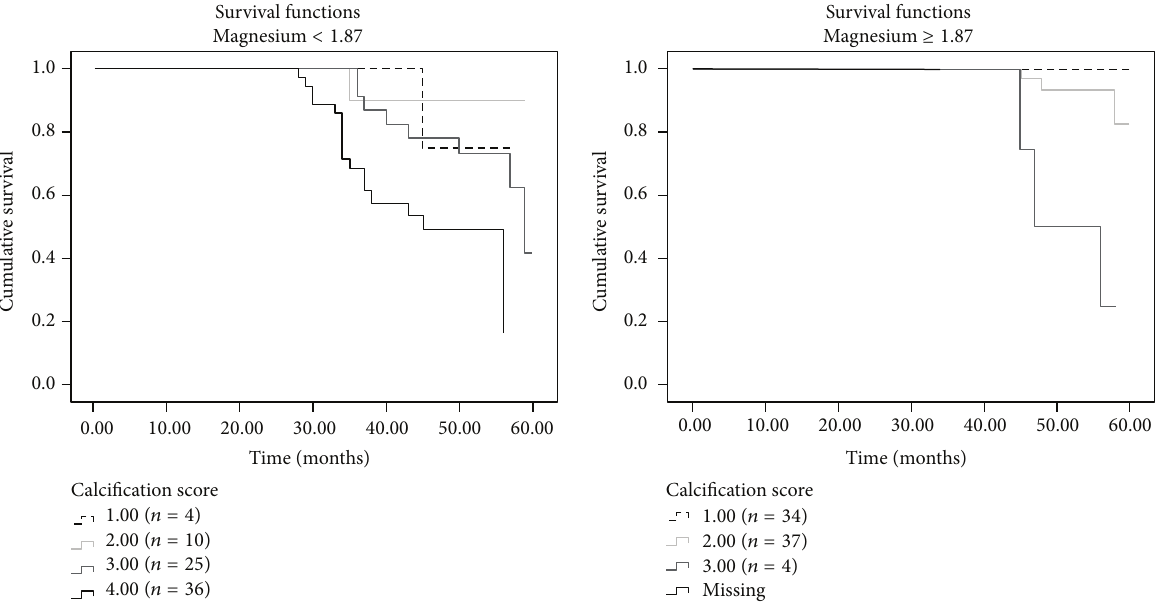
Figure 4: Survival analysis according to the serum magnesium level [mg/dL].